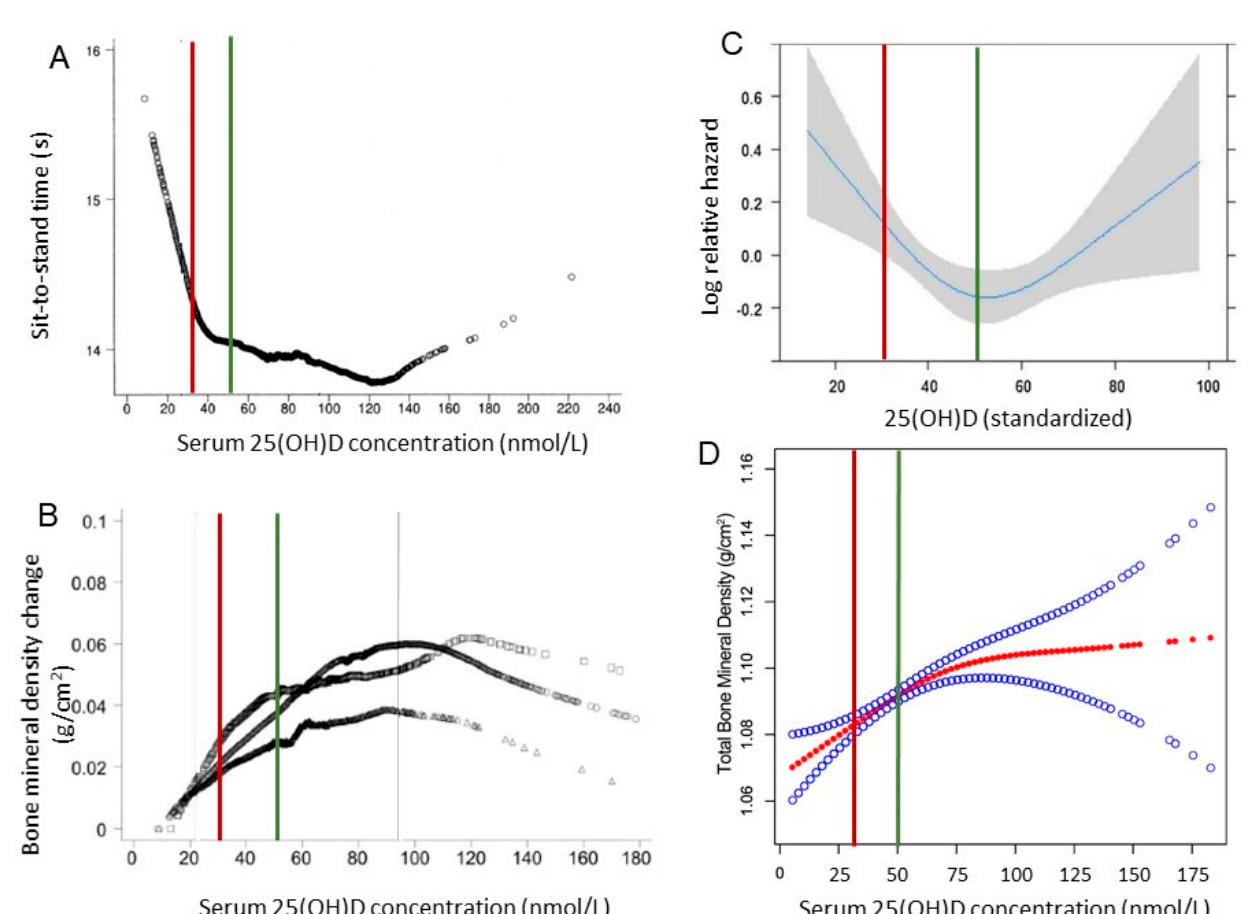
Figure 1. Serum 25(OH)D concentration relationship with different structural or functional outcomes. ( A ). Serum 25(OH)D concentrations relationship with sit-to-stand time in adults with mean age 71 years (49% female) controlled for sex, age (5-year categories), race/ethnicity, BMI, poverty income ratio, daily calcium intake, number of medical comorbidities, use of a walking device, self-reported arthritis, activity level, and month of vitamin D measurement. From [47]. ( B ). Serum 25(OH)D concentration relationship with bone mineral density in adults ≥ 50 years after adjustment for sex, age, BMI, smoking, calcium intake, estrogen use, month of vitamin D measurement, and poverty income ratio. From [47]. ( C ). Spline curve describing the association between 25(OH)D concentration and recurrent fallers in the total population. From [49]. ( D ). The association between serum 25(OH)D level and total bone mineral density from NHANES 2001–2006 among 5990 adolescents (12–19 years). Solid red line represents the smooth curve fit between variables. Blue band represents the 95% confidence interval from the fit. Adjusted for age, gender, race/ethnicity, income to poverty ratio, education, physical activity, body mass index, calcium use. From [50]. Vertical line indicates vitamin D deficiency cutoff, i.e., serum 25(OH)D < 30 nmol/L (red), used in setting DRI [46] and insufficiency cutoff, i.e., serum 25(OH)D < 50 nmol/L (green), used in updating DRI [26].